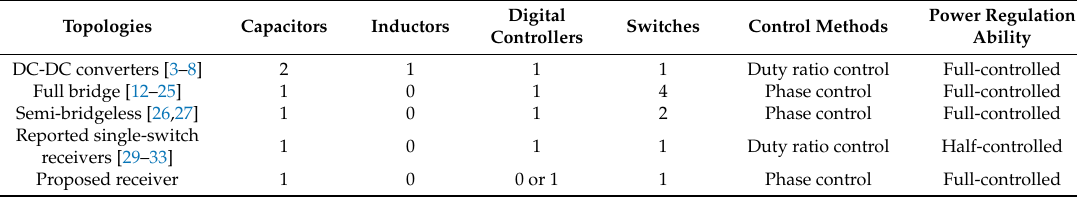
Table 3. Comparisons among different receivers for WPT